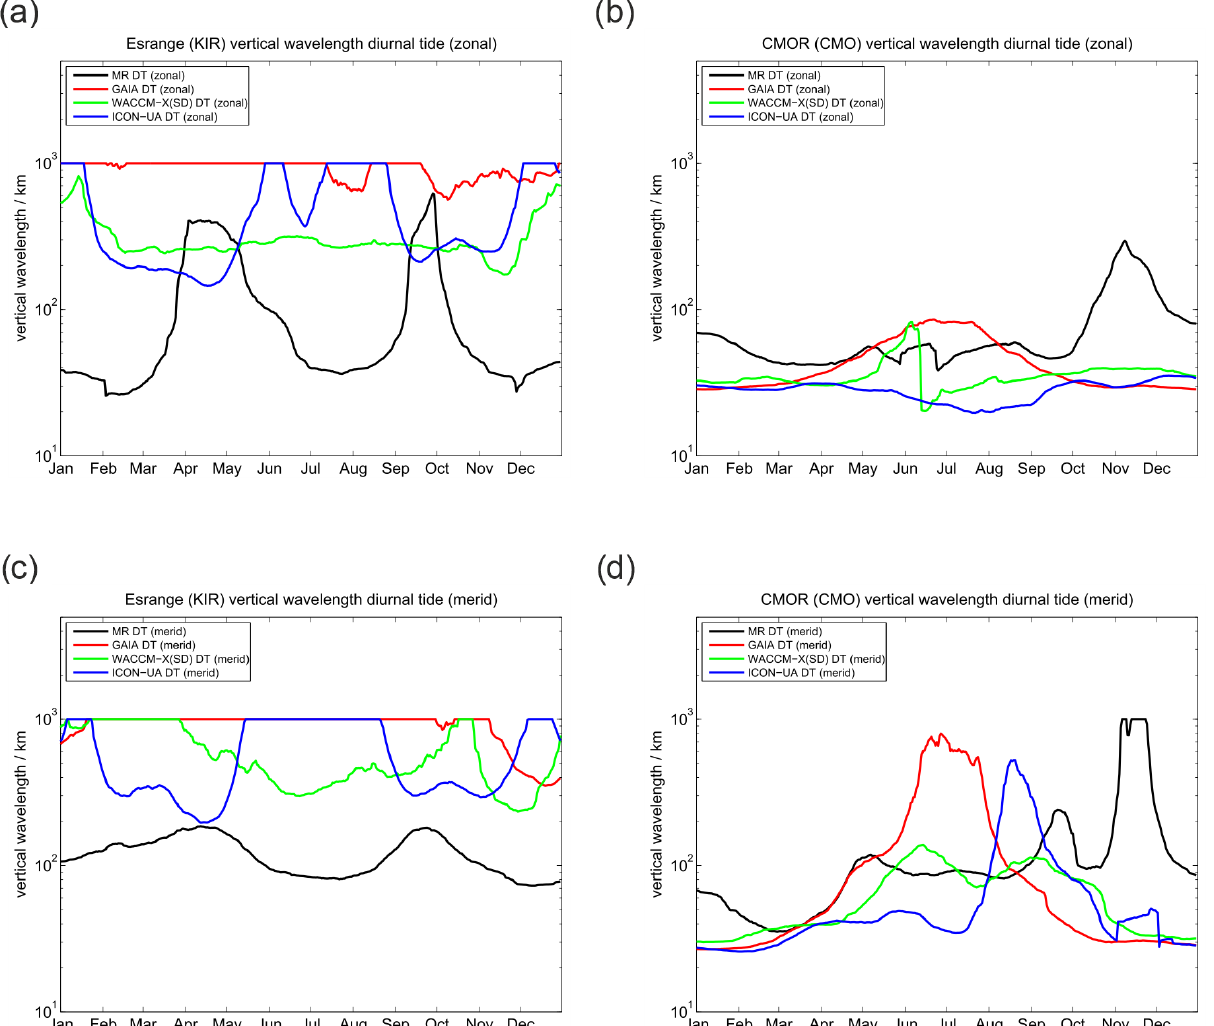
Figure A4. The same as Fig. 5, but for KIR and